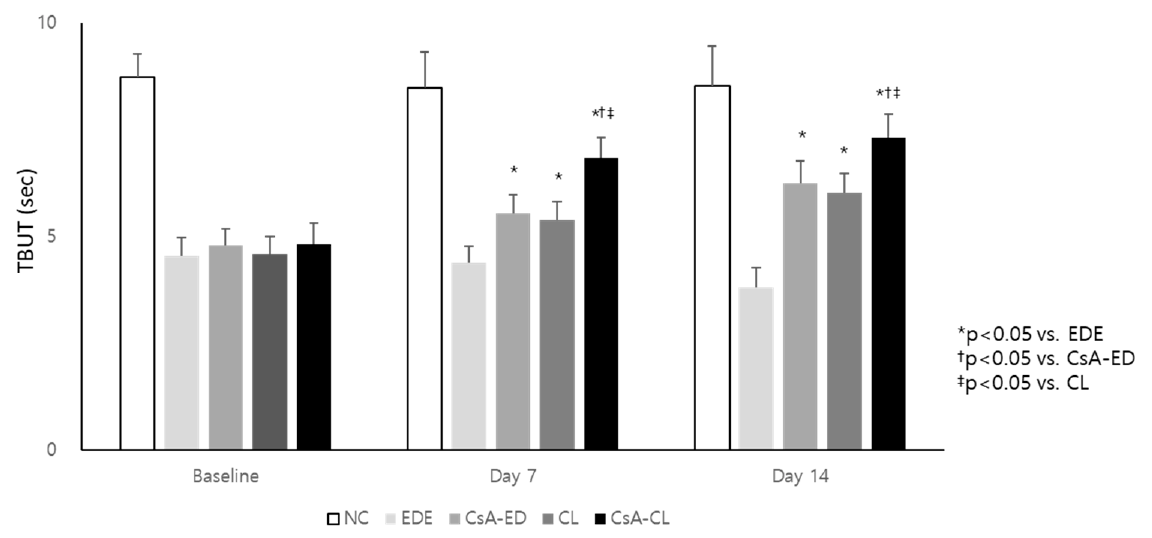
Figure 4. The tear film break-up time (TBUT) at baseline and after 7 and 14 days of treatment. All data are presented as mean and SD. NC: normal control; EDE: experimental dry eye; CsA-ED: cyclosporine A eye drop; CL: contact lens; CsA-CL: cyclosporine A-loading pH-responsive contact lens. The corneal fluorescein staining scores were 1.50 ± 1.52, 2.33 ± 1.21, and 2.83 ± 1.94 in the NC group, 9.67 ± 1.03, 10.33 ± 1.51, and 11.33 ± 1.36 in the EDE group, 9.83 ± 0.75, 8.00 ± 1.41, and 7.17 ± 1.17 in the CsA-ED group, 9.83 ± 0.98, 8.00 ± 0.89, and 7.67 ± 1.51 in the